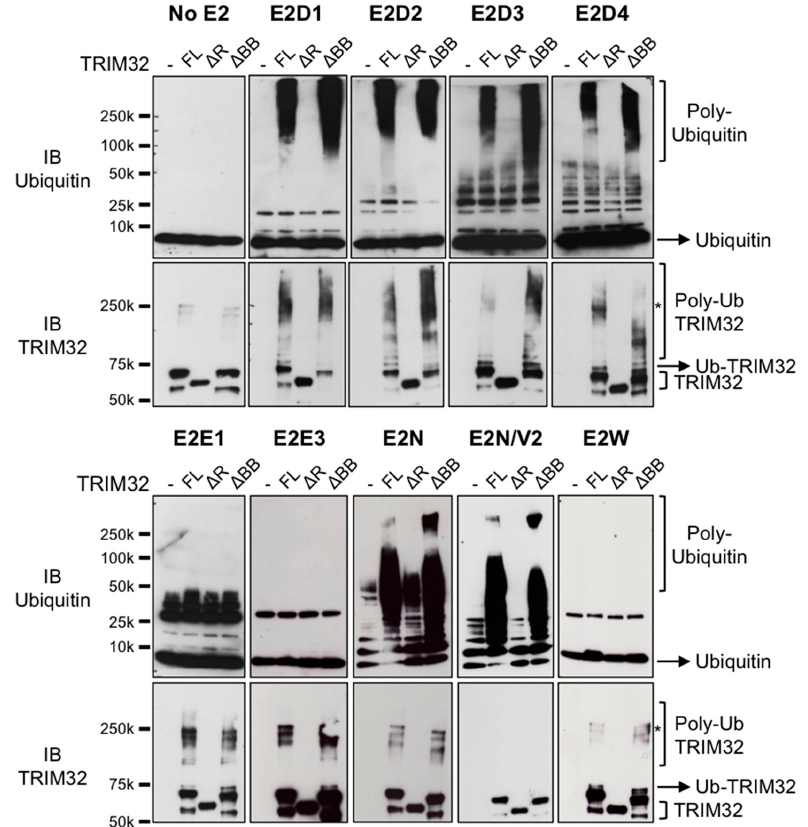
Figure 4. Deletion of the B-box does not prevent TRIM32 catalytic activity and does not change UbE2 specificity. Recombinant full-length TRIM32 (FL), Δ RING ( Δ R) or Δ B-box ( Δ BB) was used as E3 ligase in in vitro ubiquitination reactions with a panel of UbE2-conjugating enzymes as indicated. In each panel, the first lane is the reaction with no E3 ( − ). Control reactions without the addition of E2 enzymes are shown (No E2). Proteins were resolved by SDS-PAGE and membranes incubated with anti-ubiquitin (top panels) or anti-TRIM32 (bottom panels). Asterisks indicate SDS-resistant high molecular weight species likely representing TRIM32 oligomers (see text below).